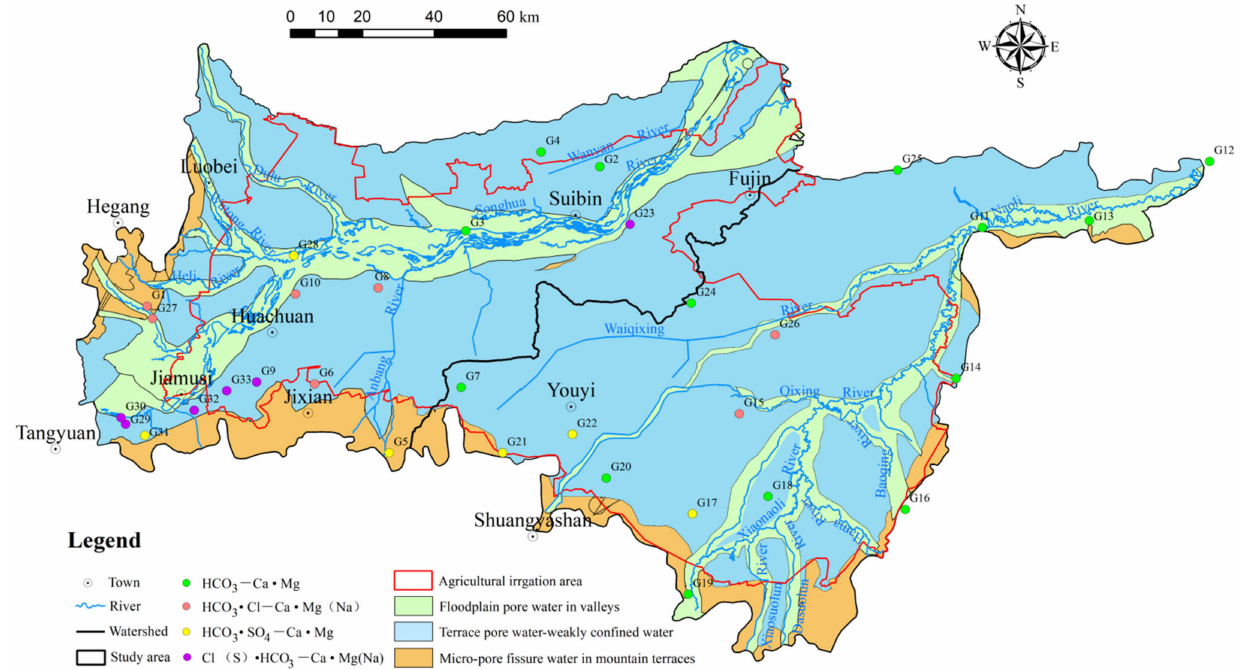
Figure 1. Study area and location of water sampling